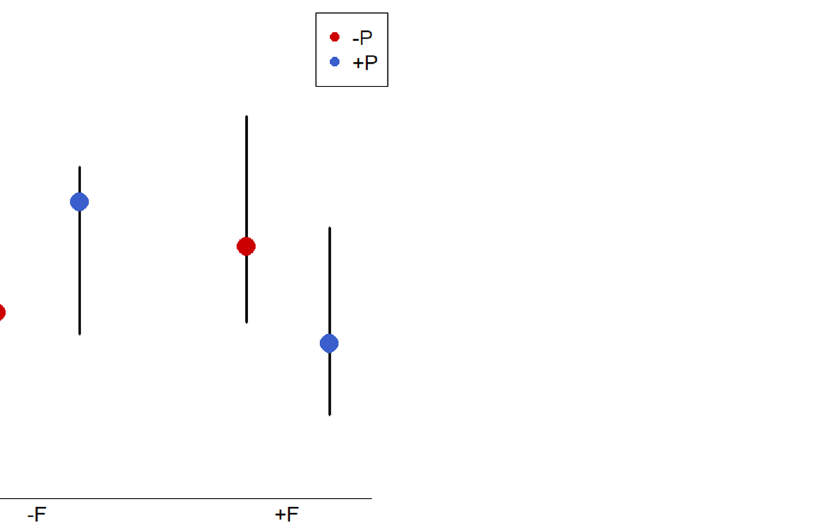
Figure 2. Total egg number produced in the first three clutches by females reared with ( + F) or without ( − F) older group members that were exposed to predator experience ( + P treatment, blue) or no predator experience ( − P treatment, red). Medians and interquartile ranges are